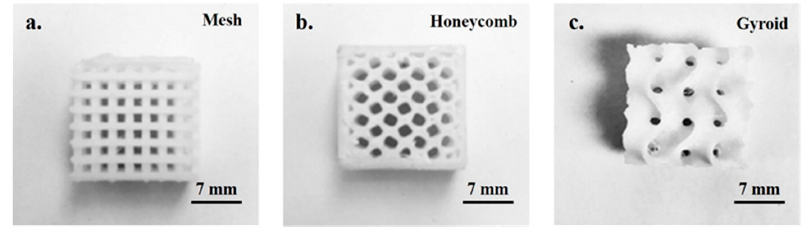
Figure 1. Digital pictures of 3D printed mesh ( a ), honeycomb ( b ), and gyroid ( c ) structures of identical dimensions.